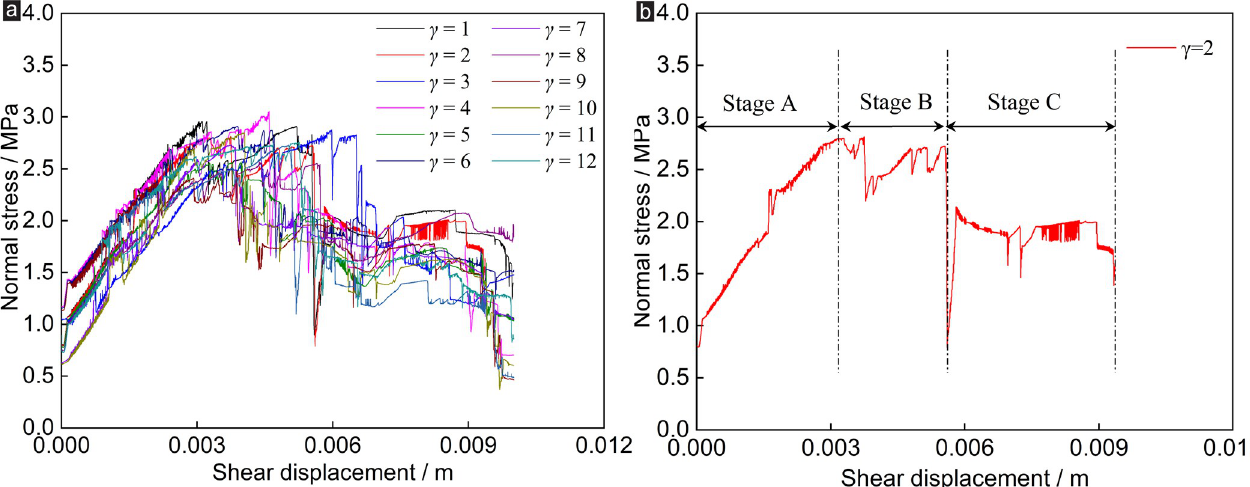
Fig 5. Effect of γ on normal stress of rock joints under CNS conditions: (a) normal stress vs. shear displacement, (b) normal stress vs. shear displacement of γ = 2.